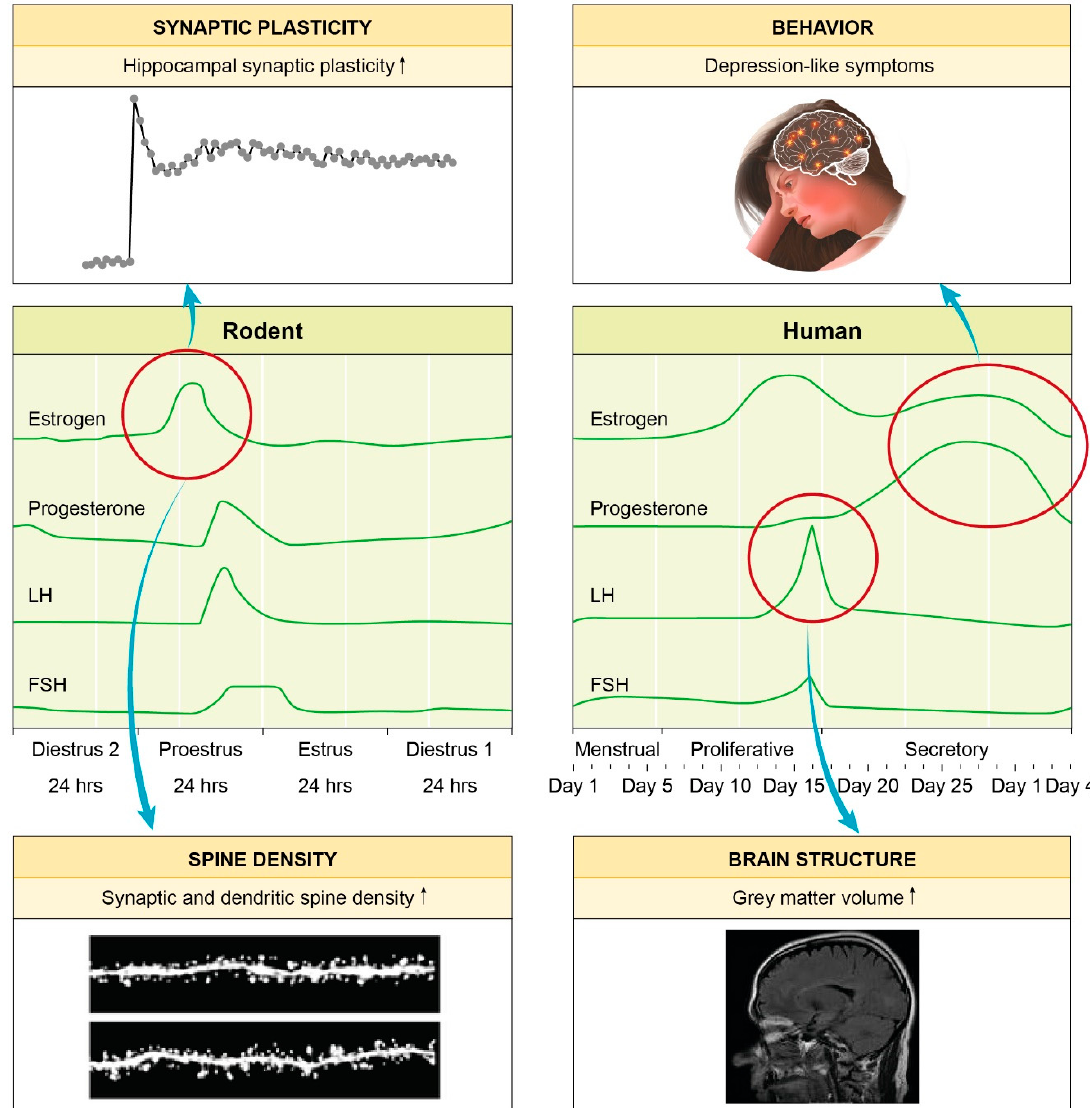
Figure 1. Highlighting the hormonal impact on the female brain: changes throughout the menstrual cycle. Rodents and women share a similar menstrual cycle pattern. Alterations in hormone levels are known to play an important role in neurobiology and mental health. The increased levels of oestrogen in the rodent proestrus phase have been reported to guide an increase in both hippocampal spine density [30] and plasticity [31]. In women, a significant increase in grey matter volume was found around ovulation [32]. The decrease of circulating hormones at the end of the menstrual cycle may induce depression-like symptoms [33].